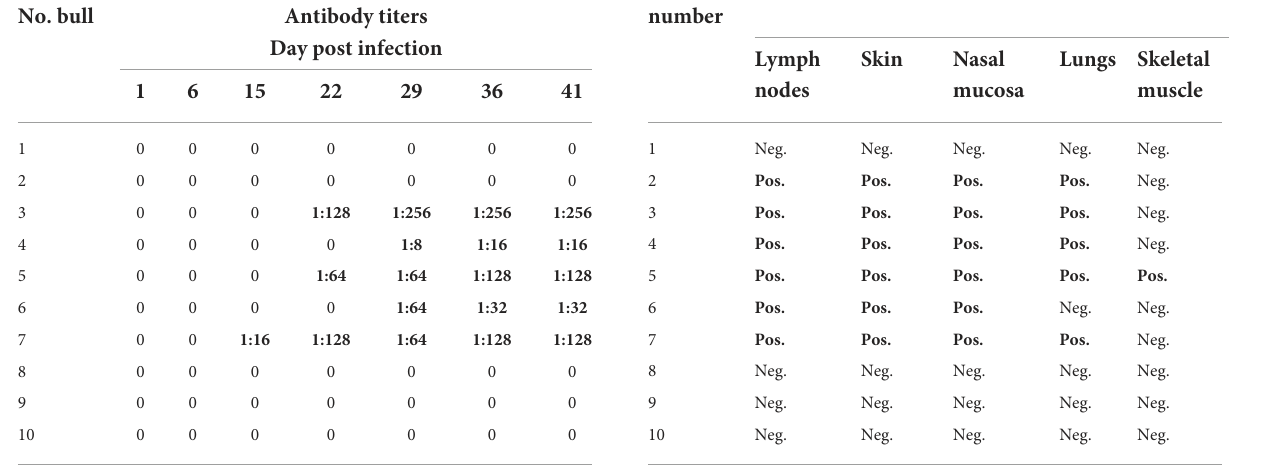
TABLE 5 LSD virus isolation in cell culture from nasal swabs of experimental animals. Day post infection (dpi) Animal